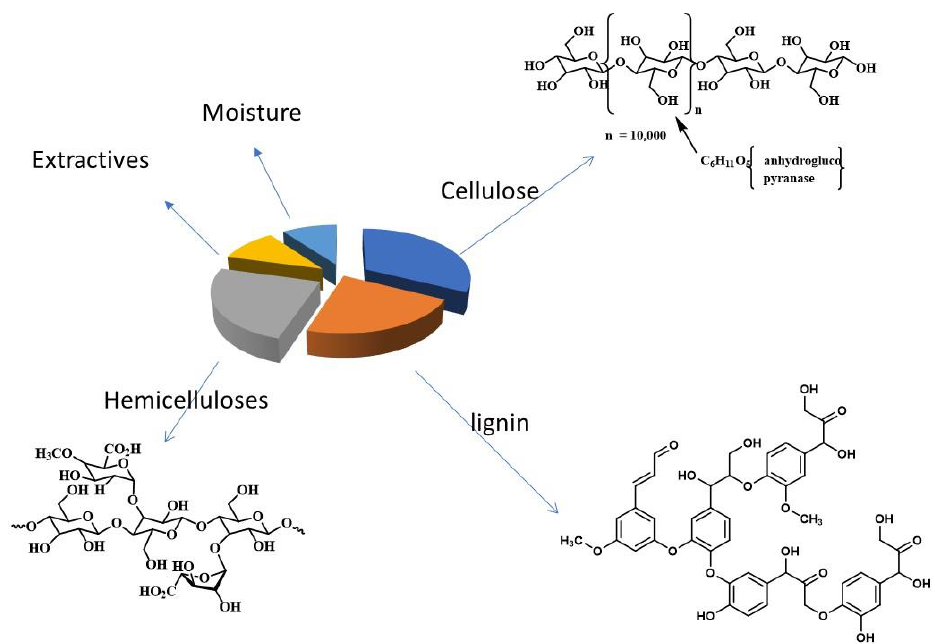
Figure 1. A diagram summarizing the components of OISW.